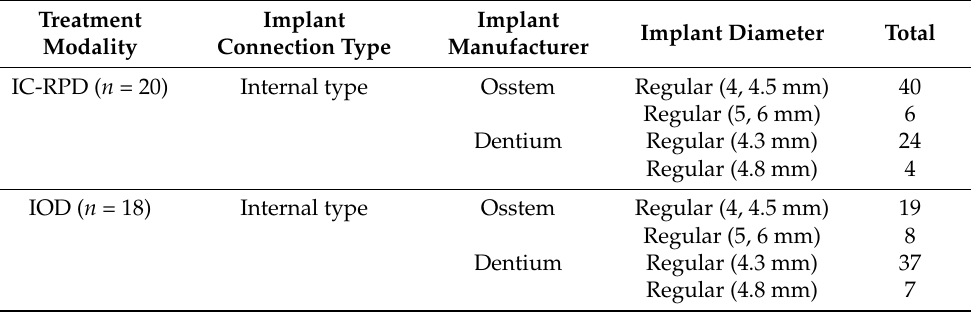
Table 2. Numbers of implants for IC-RPD and IOD and related